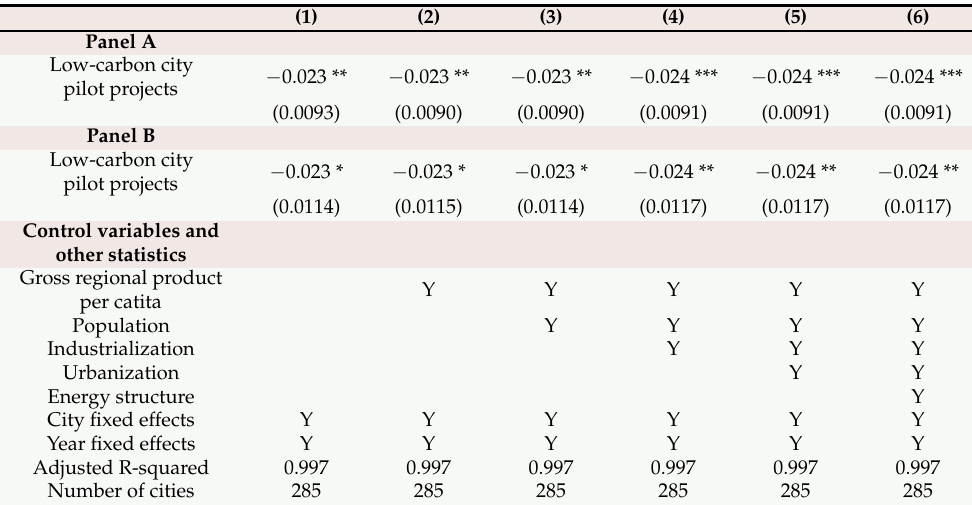
Table 2. Estimates in the impact on carbon from propensity-score-matching difference-in- differences